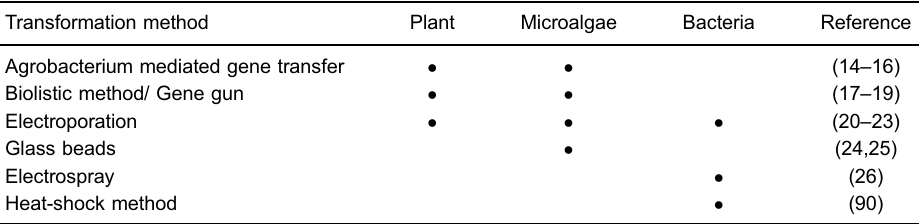
Table 1. Transformation techniques in plants, microalgae, and bacteria. Transformation